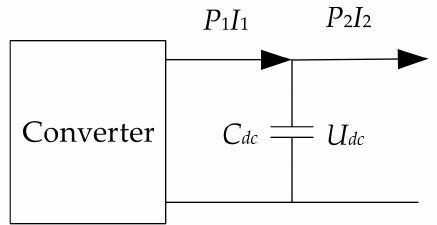
Figure 4. Voltage–current relationship at the DC side of the